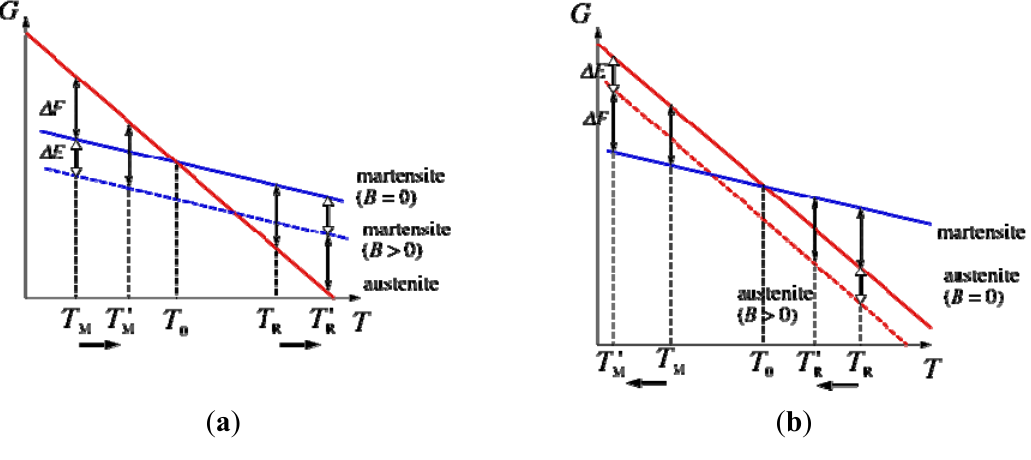
Figure 6. Temperature and magnetic field dependence of Gibbs’s free energy. ( a ) The diagram when the martensite phase is ferromagnetic and the austenite phase is paramagnetic. Δ F and Δ E indicate the motive force for inducing a martensite transition, and the Zeeman energy, respectively. Dashed bold line indicates the free energy under the magnetic field at the martensite phase. ( b ) The diagram when the martensite phase is paramagnetic and the austenite phase is ferromagnetic. Dashed bold line indicates the free energy under the magnetic field at the austenite